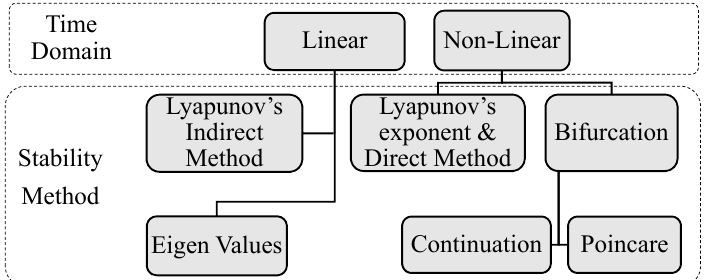
Figure 2. Tools for Stability Studies in Time Domain.